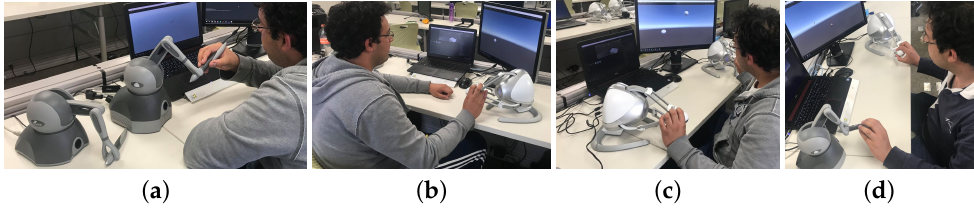
Figure 8. User working on the haptic connection scenario. ( a ) User is using a Geomagic Touch, ( b ) User is using a Novint Falcon, ( c ) User is using two Novint Falcon, and ( d ) User is using a Novint Falcon and a Geomagic Touch.